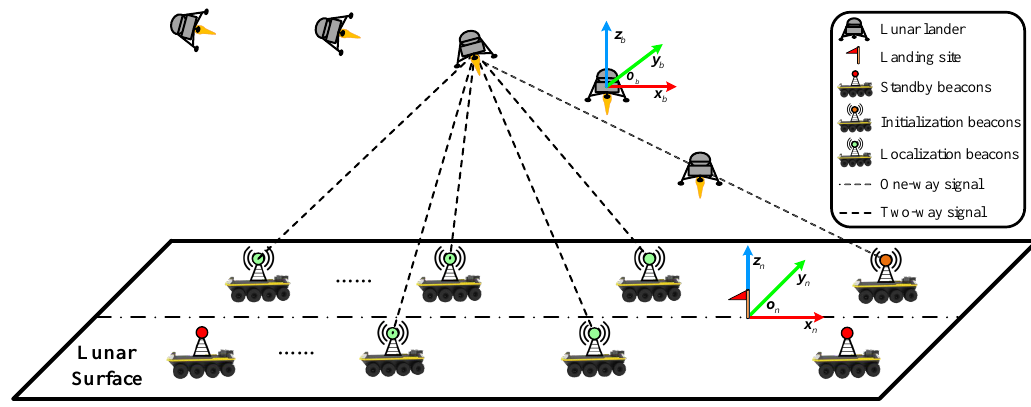
Figure 1. Overview of the proposed distributed radio beacon/inertial measurement unit (IMU)-integrated localization scheme and definitions of the landing frame L (east, north and up (ENU)) and the body frame B (front–left–up